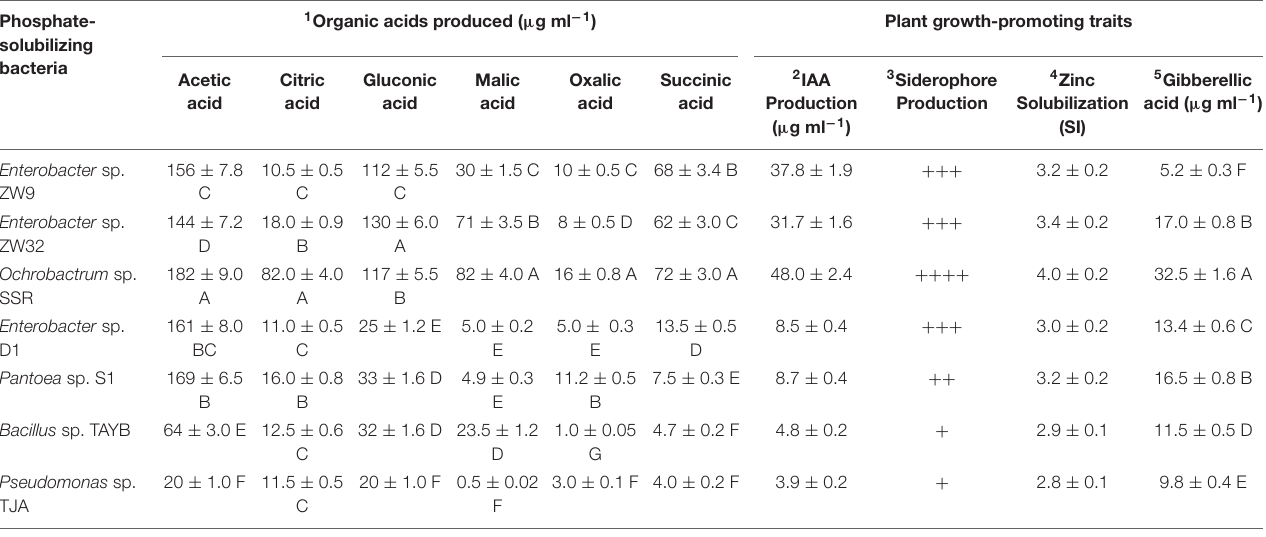
( Figure 3 ). Phylogenetic analysis of partial DNA sequence of pqqE gene for Ochrobactrum strain SSR (GenBank accession